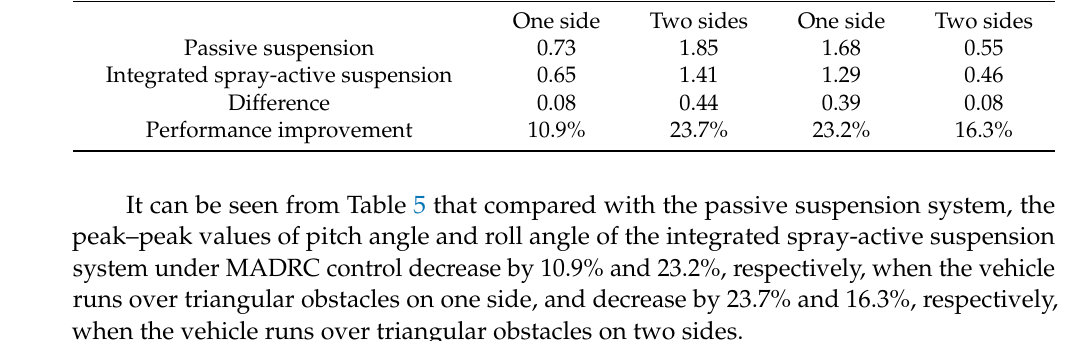
Figure 14. ( a ) Pitch angle comparison curve of wheel-crossing obstacle on two sides; ( b ) roll angle comparison curve of wheel-crossing obstacle on two sides. Table 5. Peak–peak value of vehicle